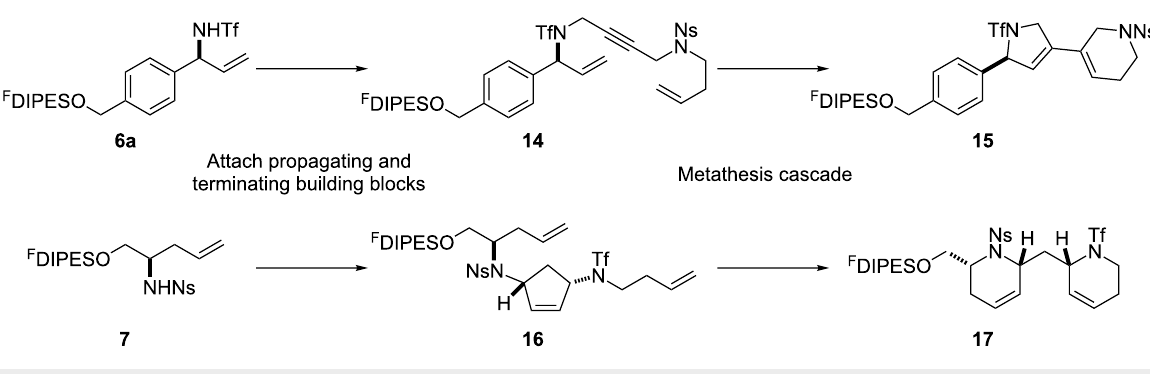
Scheme 2: Overview of the proposed synthetic approach. F DIPES = diisopropyl(3,3,4,4,5,5,6,6,7,7,8,8,9,9,10,10,10-heptadecafluorodecyl)silyl; Ns = o -nitrophenylsulfonyl.